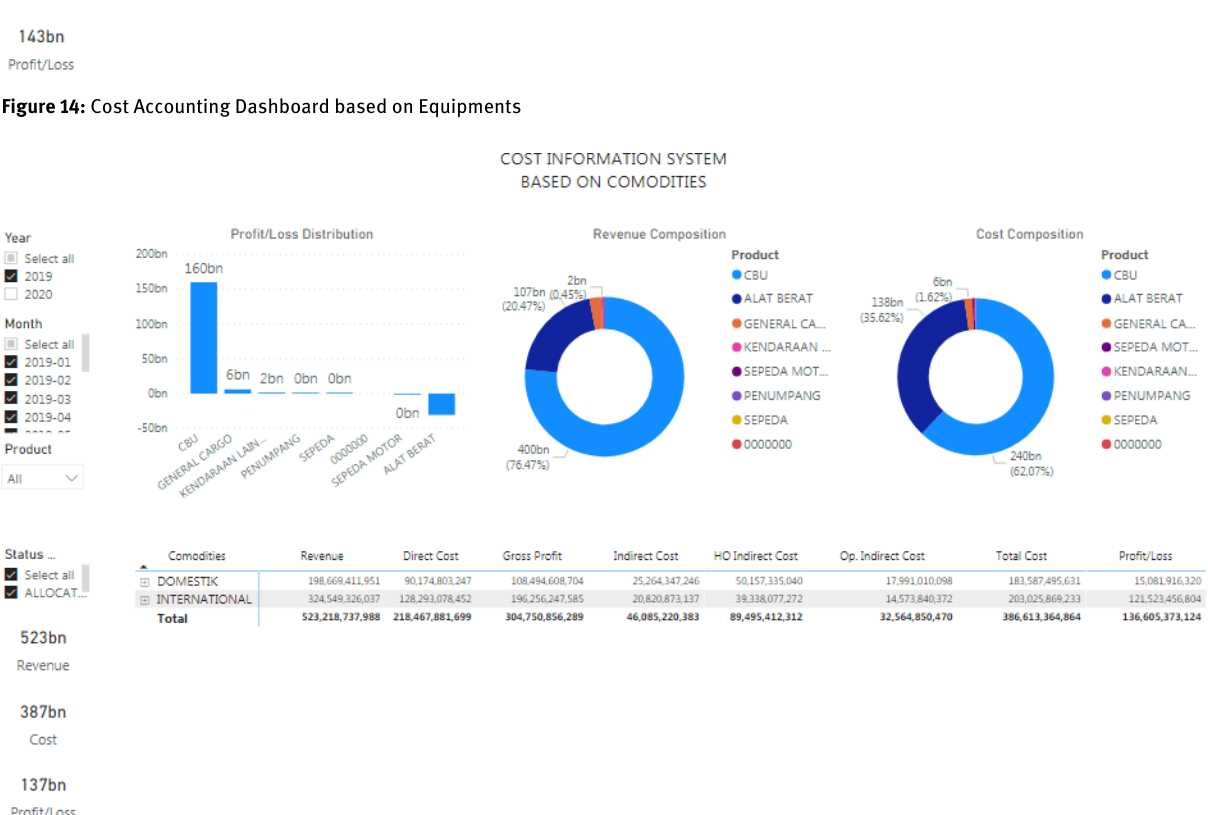
Figure 15: Cost Accounting Dashboard based on Commodities